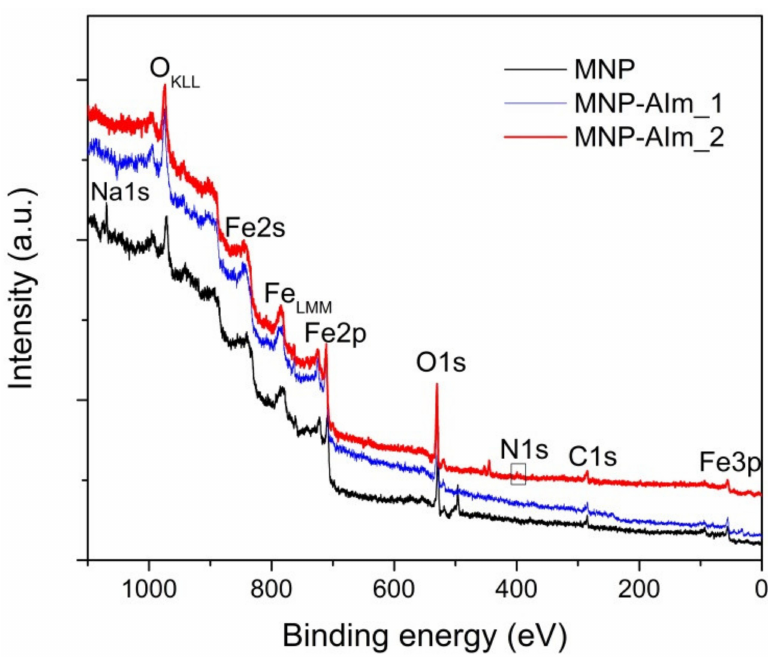
Figure 6. XPS survey spectra for MNP, MNP-AIm_1 and